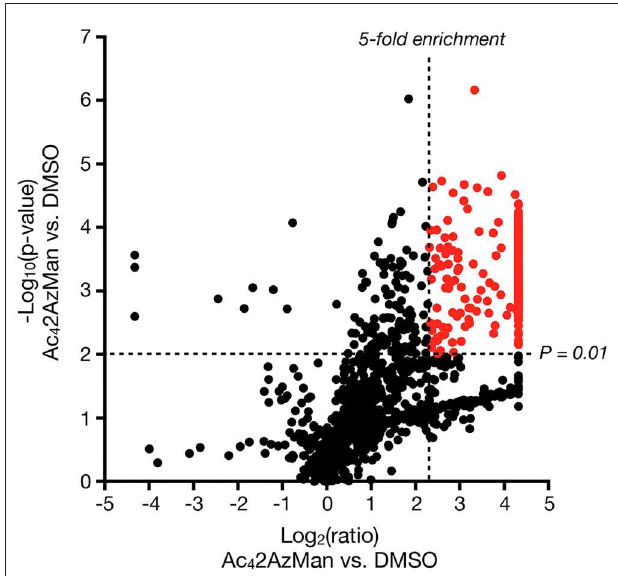
FIGURE 5 | Ac 4 2AzMan labels a wide variety of intracellular proteins. H1299 cells were treated with either Ac 4 2AzMan (200 µ M) or DMSO vehicle for 16h. Labeled proteins were then enriched using neutravidin beads after CuAAC with alkyne-biotin. Proteins were then identified using label free quantitation after on-bead trypsinolysis and LC-MS/MS. The results are shown as a Volcano Plot (x-axis: log 2 ratio of MCR to vehicle, y-axis; –log 10 p -value). Significantly enriched proteins that differ at least 5 linear-fold with a p < 0.01 (Student’s t -test) are marked in